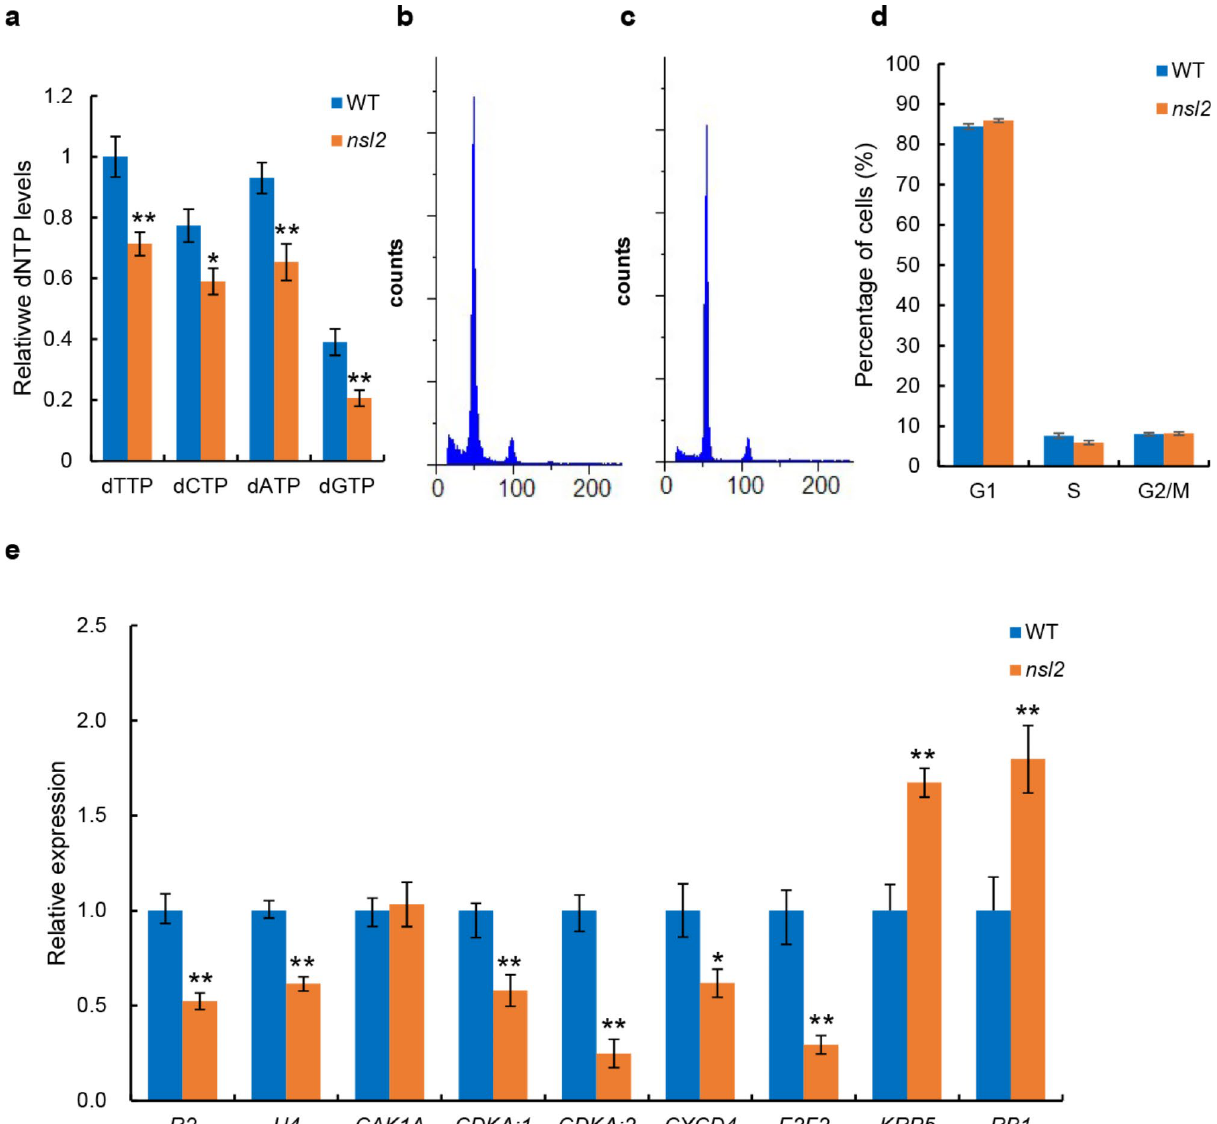
Fig. 5 Involvement of NSL2 in cell division in leaves. a : Relative dNTP levels in wild-type and nsl2 leaves. The values were normalized to the wild-type (WT) dNTP levels. Error bars, ±SD ( n = 3). b and c : Flow cytometry measurements of nuclei from the WT (b) and nsl2 plants (c). d : Quantification of the DNA profiles of WT and nsl2 plants. e : RT-qPCR analysis the transcript levels of cell division related genes in leaves of WT and nsl2 plants. The P-values were determined using Student’s test. *P < 0.05, **P <